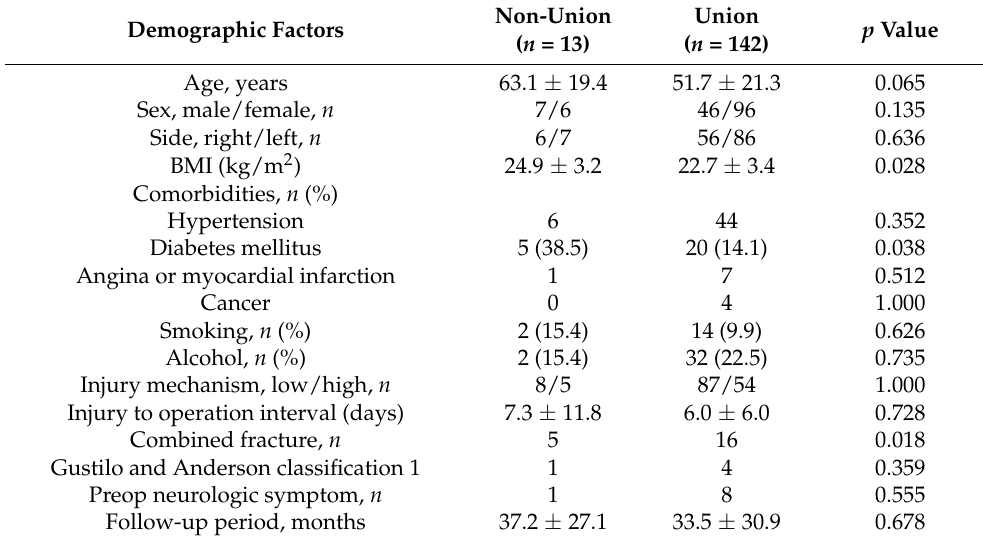
Table 2. Comparison of demographic factors between non-union patients and union